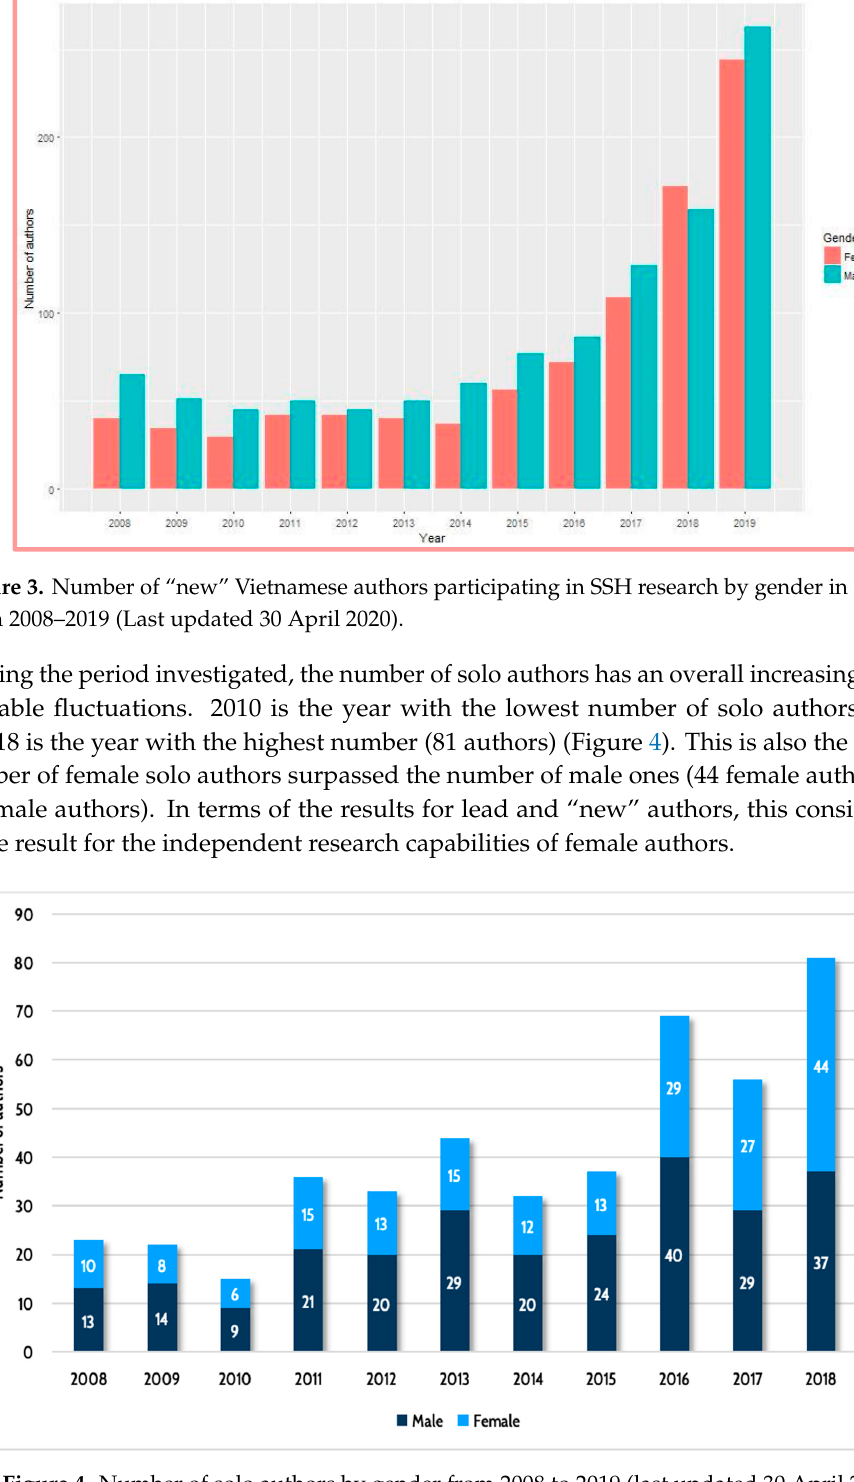
Figure 4. Number of solo authors by gender from 2008 to 2019 (last updated 30 April 2020).